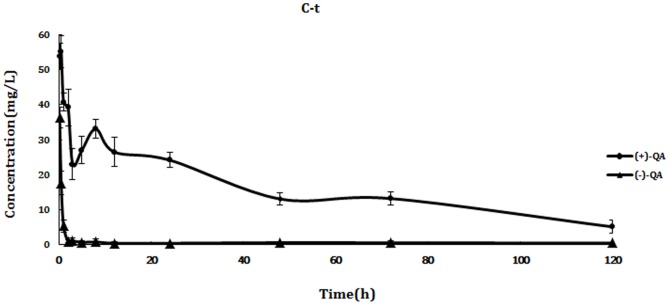
The concentration-time curves of QA enantiomers in blood after intravenous administration.Each point represents the mean ± SD (n = 6). Blood QE level was not detected through the whole study.